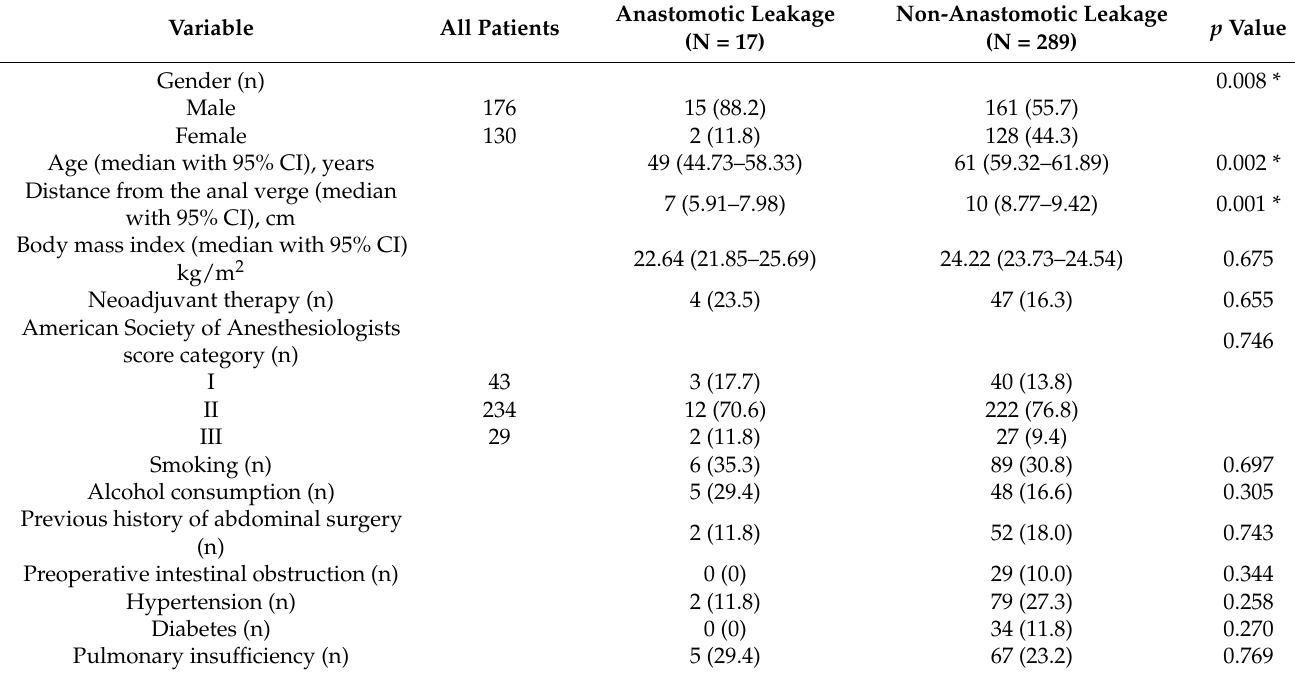
Figure 1. The flow diagram of study protocol.